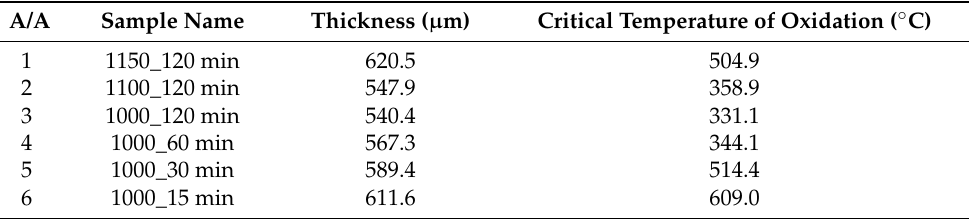
Table 4. Calculated parameters from the synthesis of CrSi 2 samples at various temperatures and times.